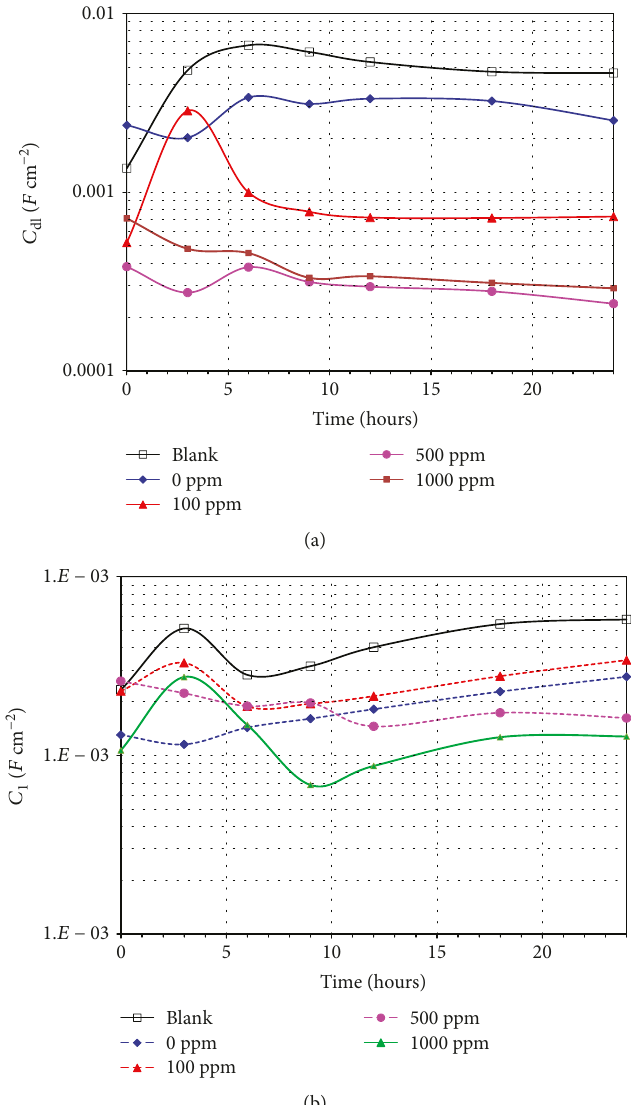
Figure 15: Evolution of the (a) C concentrations of